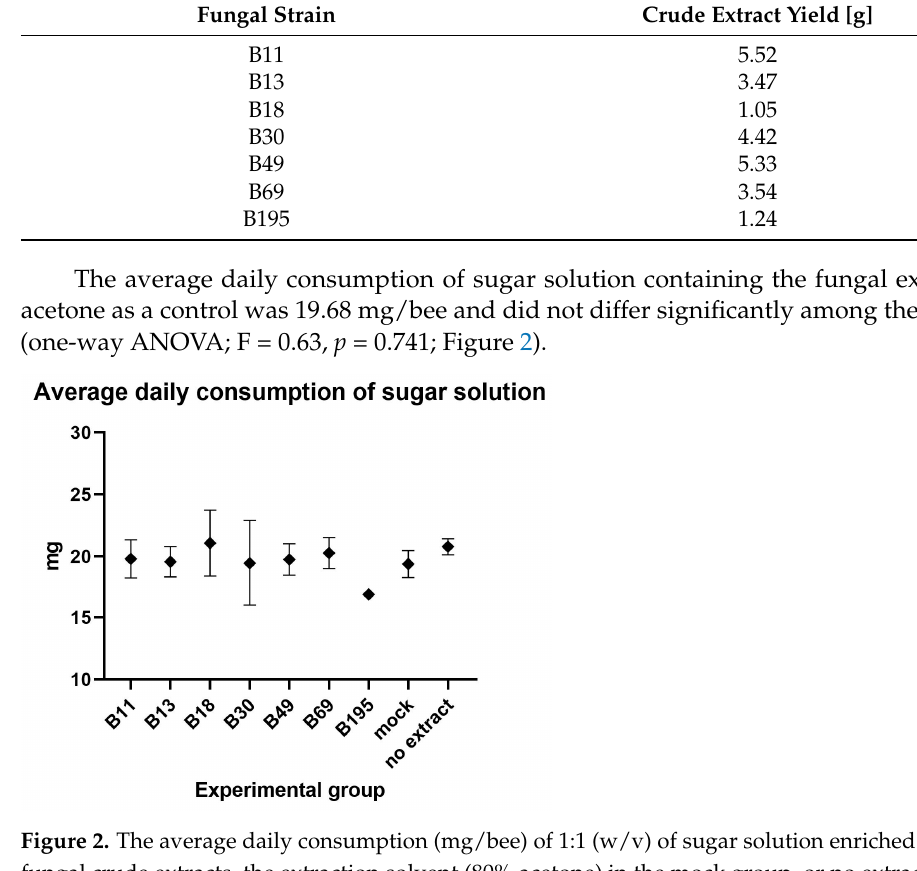
Figure 1. Seven strains of Talaromyces used in this study. The cultures were grown on malt extract agar at 25 °C for 1 week. Table 1. Crude methanol extract yields from the seven Talaromyces strains used in this study. Fungal Strain